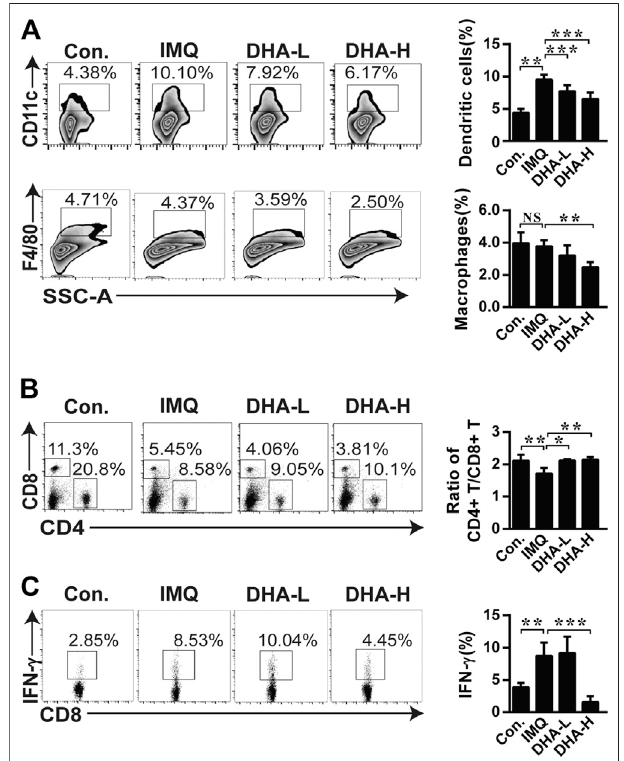
FIGURE 5 | DHA treatment altered immune cellular composition in spleens. (A) ThefrequenciesofDCs,andthefrequenciesofmacrophages. (B) Ratio of CD4 + /CD8 + T cells was analyzed by fl ow cytometry. (C) Splenocytes were stimulated by PMA and ionomycin for 4 h in the presence of brefeldin A, then frequency of IFN- γ + CD8 + T cells was determined by fl ow cytometry(DCs,** p (cid:2) 0.0027,*** p < 0.001;macrophages,** p (cid:2) 0.0011;Ratio of CD4 + /CD8 + T cells, * p (cid:2) 0.0117, ** p < 0.01; IFN- γ + CD8 + T cells, ** p (cid:2) 0.0056,*** p < 0.001). Statistical analysiswascarried outusingOne-way ANOVA analysis of variance followed by Dunnett ’ s test ( n (cid:2) 4 –